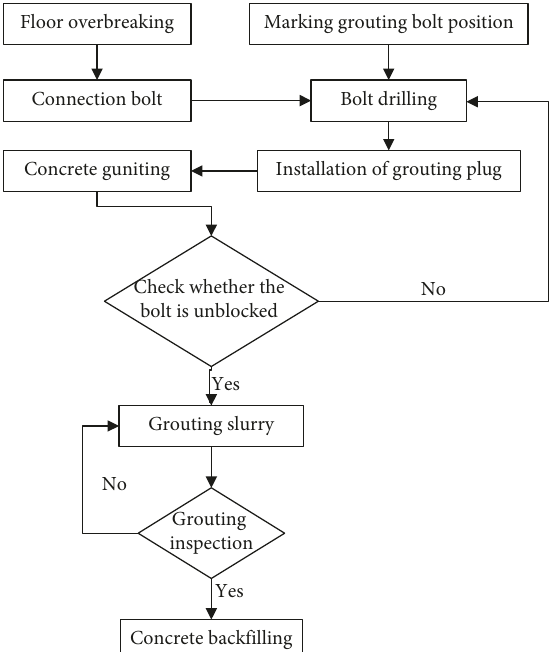
Figure 16: Construction flowchart of the roadway floor.